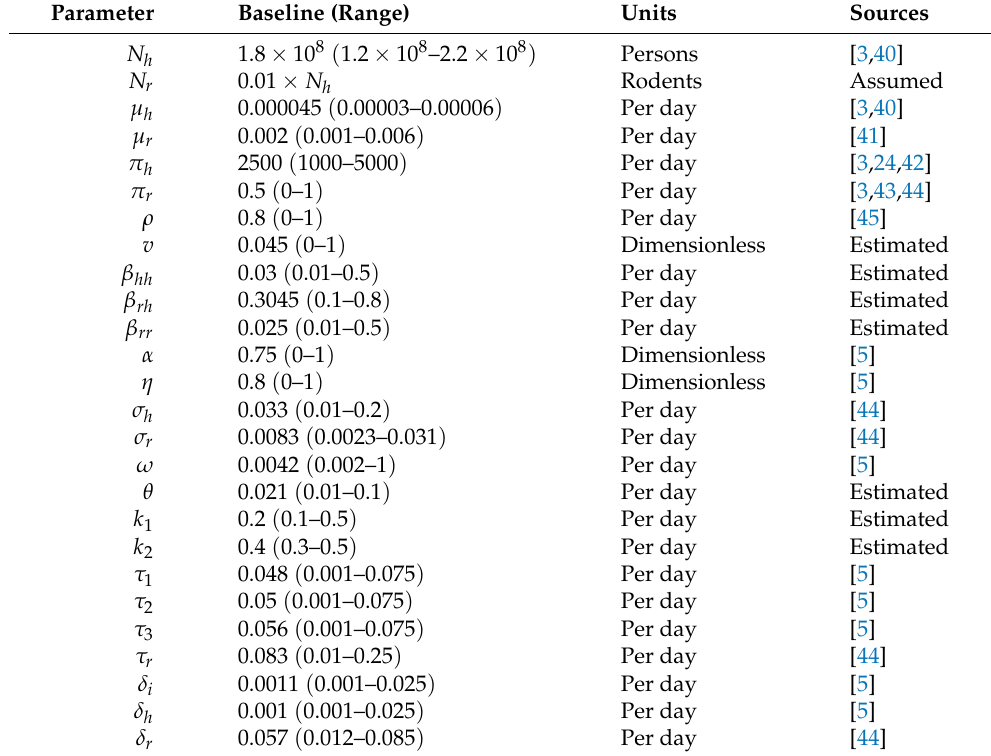
Table 2. Table summarizing model parameter values (1)